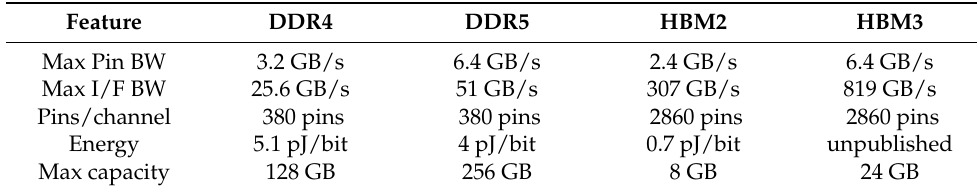
Table 1. Comparisons of various memories